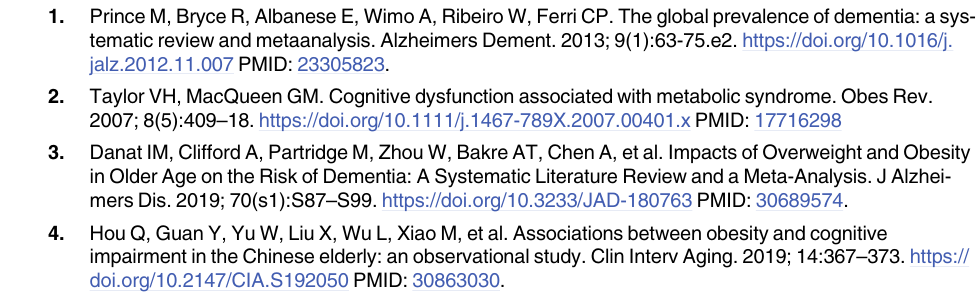
S2 Table. Mean of obesity-related indicators, stratified by cognitive status and sex. S3 Table. Multivariate linear regression analysis of the association between obesity-related indicators and MMSE score. S4 Table. Logistic regression analyses of the association of FM and FFM with cognitive impairment. S5 Table. Correlation of calf circumference with other obesity-related